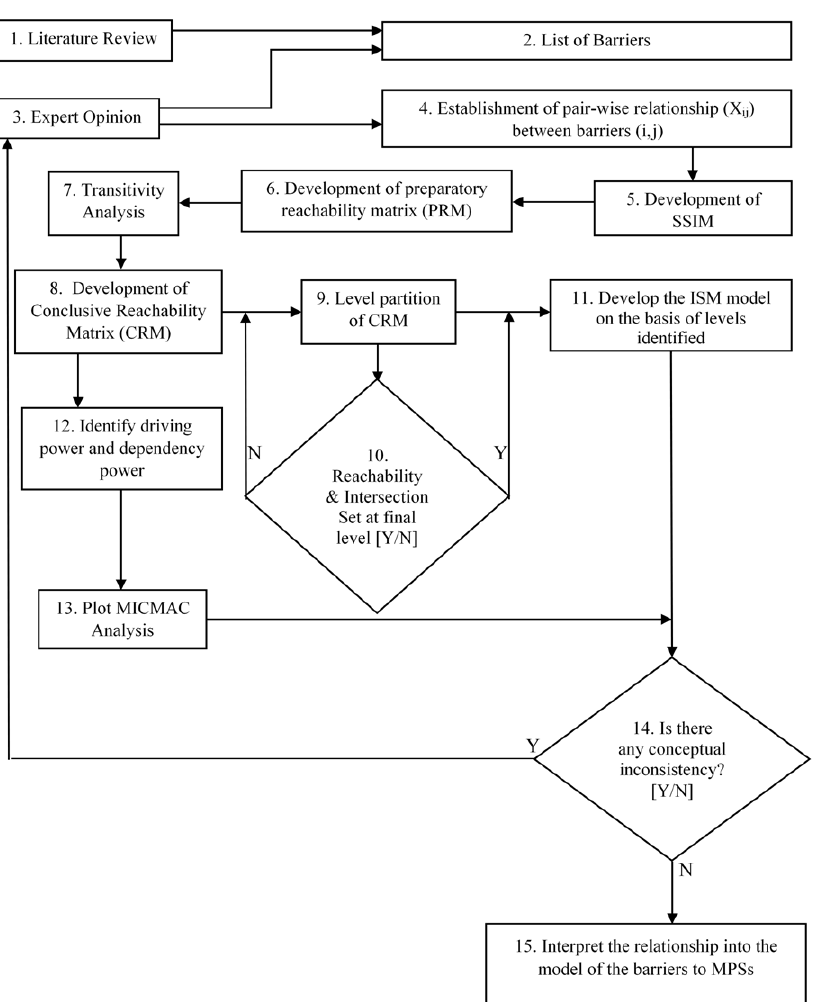
Figure 1. Flow chart for preparing the ISM model of barriers to MPSs